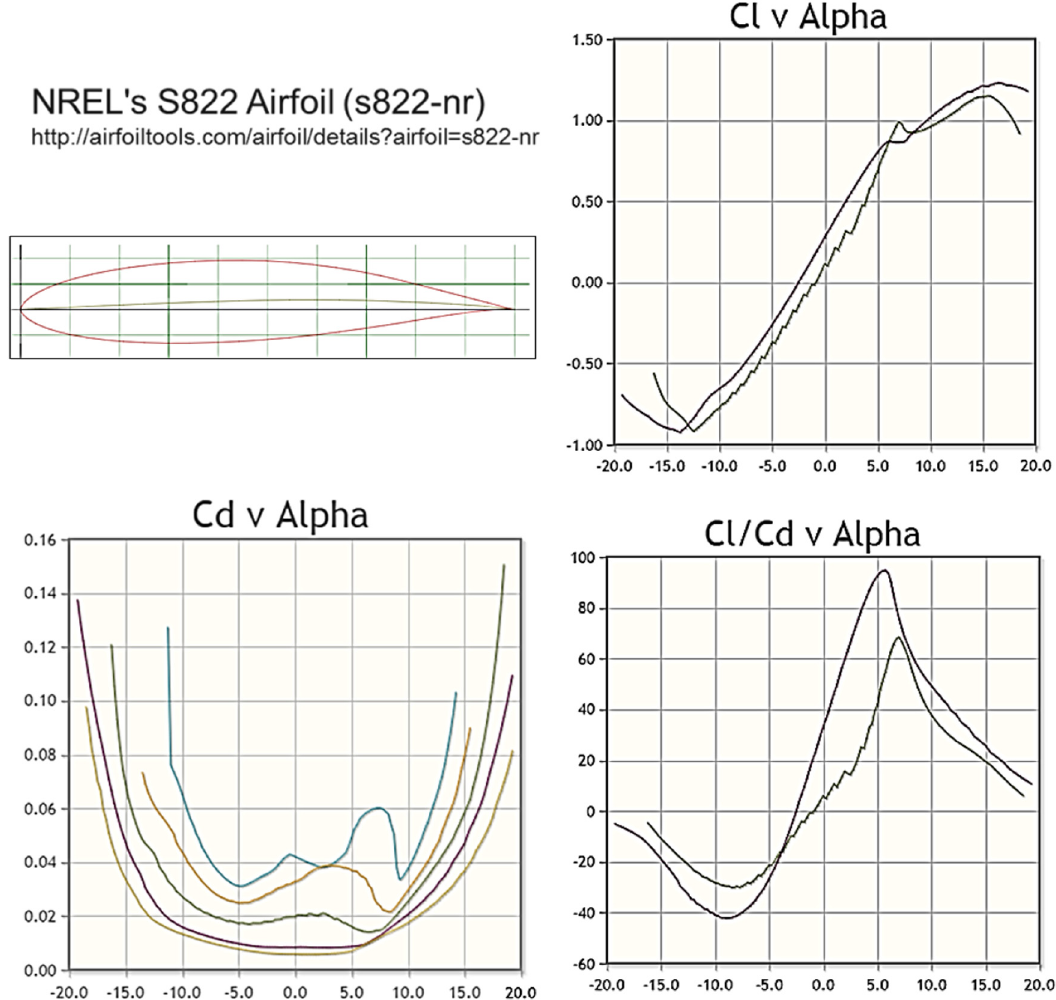
Fig. 1. Aerodynamic characteristics of NREL ’ s S822